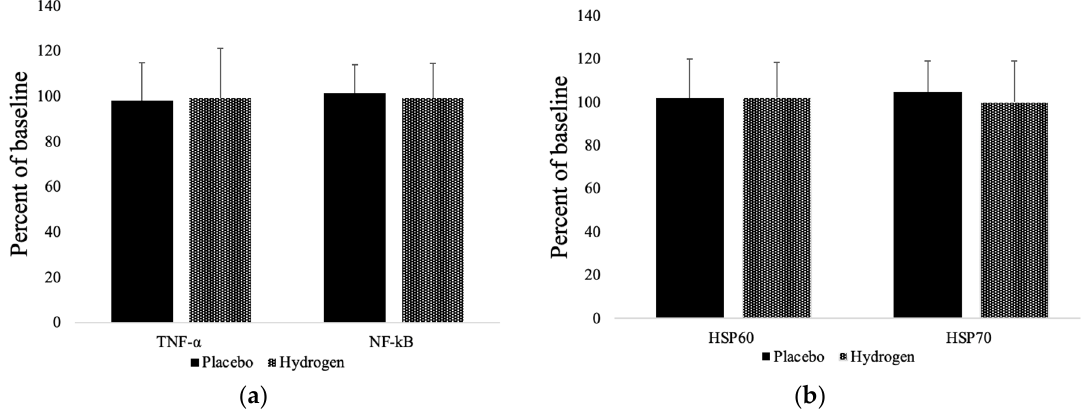
Figure 3. Markers of inflammation (a) and levels of heat shock proteins (b). HSP60 = heat shock protein 60; HSP70 = heat shock protein 70; TNF- α = tumor necrosis factor alpha; NF- κ B = nuclear factor kappa B. n = 13 for placebo group, n = 17 for hydrogen group, p < 0.05.